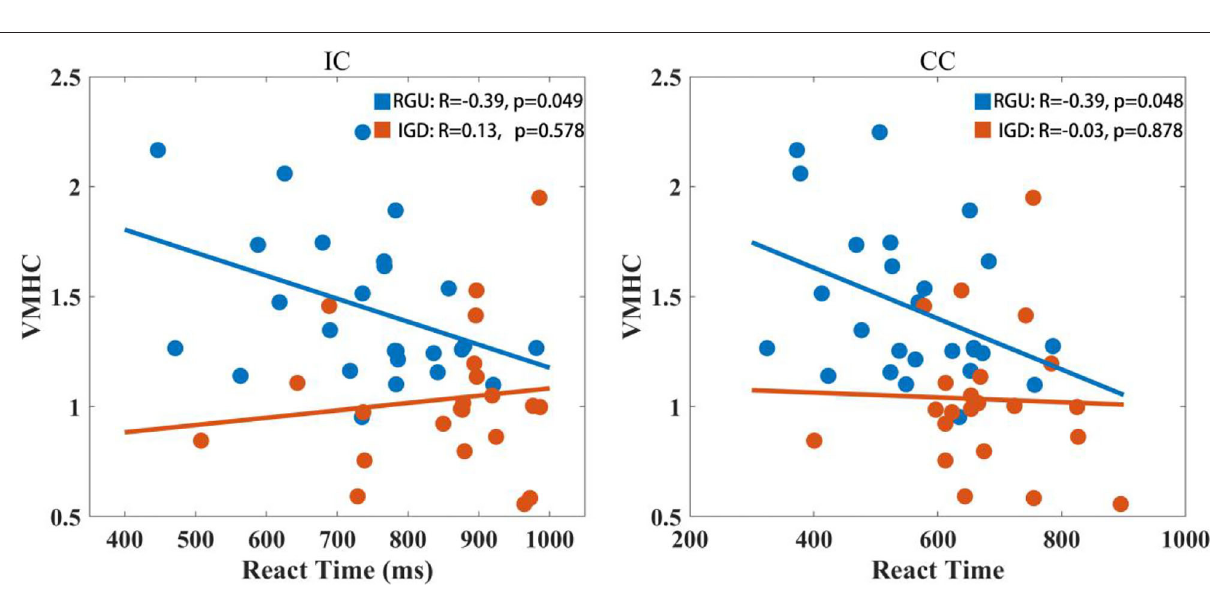
severity of IGD, was positively correlated with impulsivity scores, which was essentially consistent with previous studies (33,